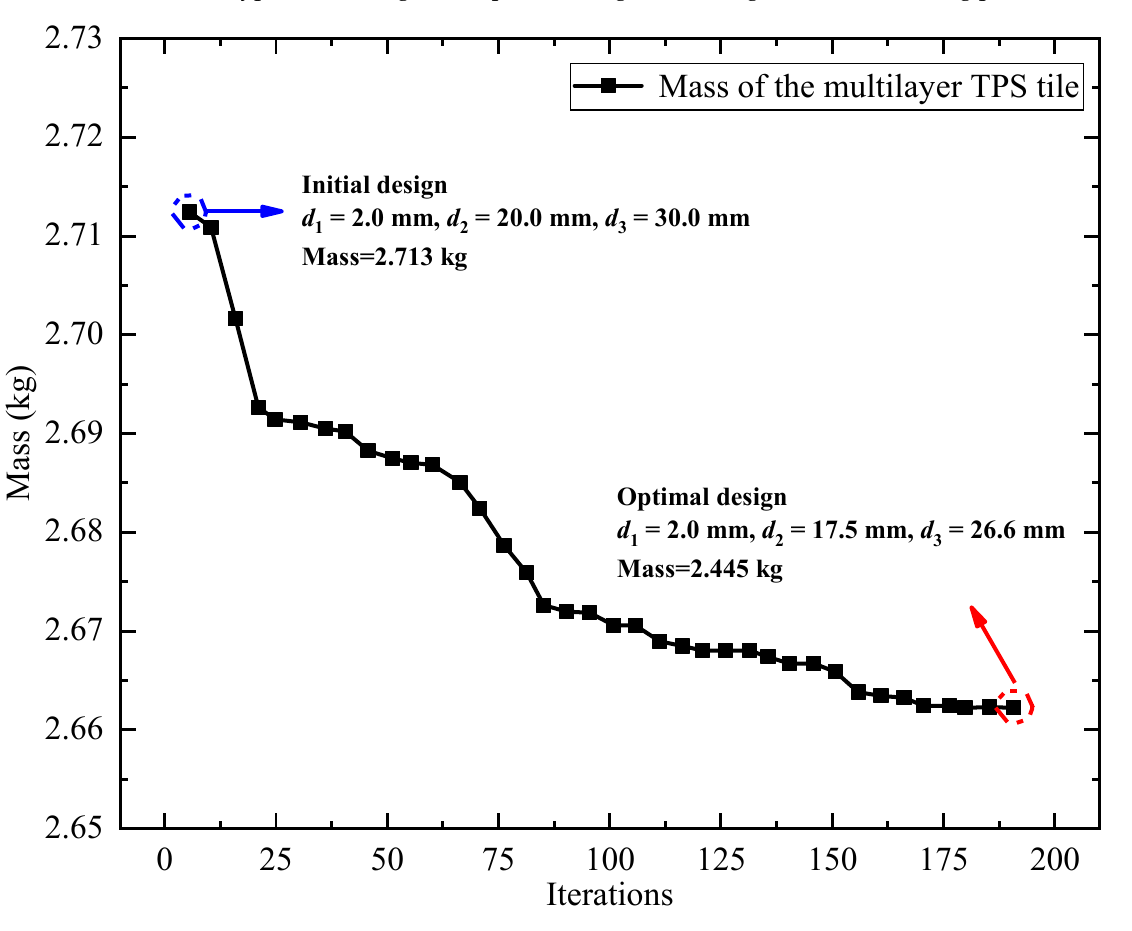
Figure 9. Illustration of the optimization processes.